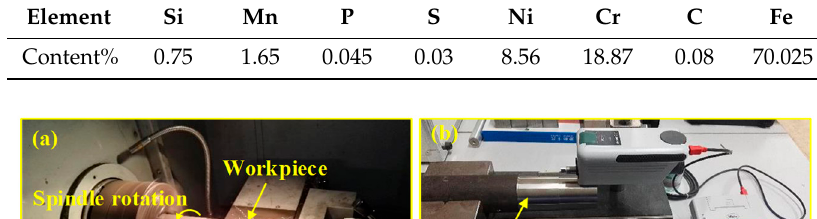
− 5 Table 2. Tool and workpiece material performance parameters. Material 206 Table 3. Chemical composition of AISI 304 stainless steel. Element